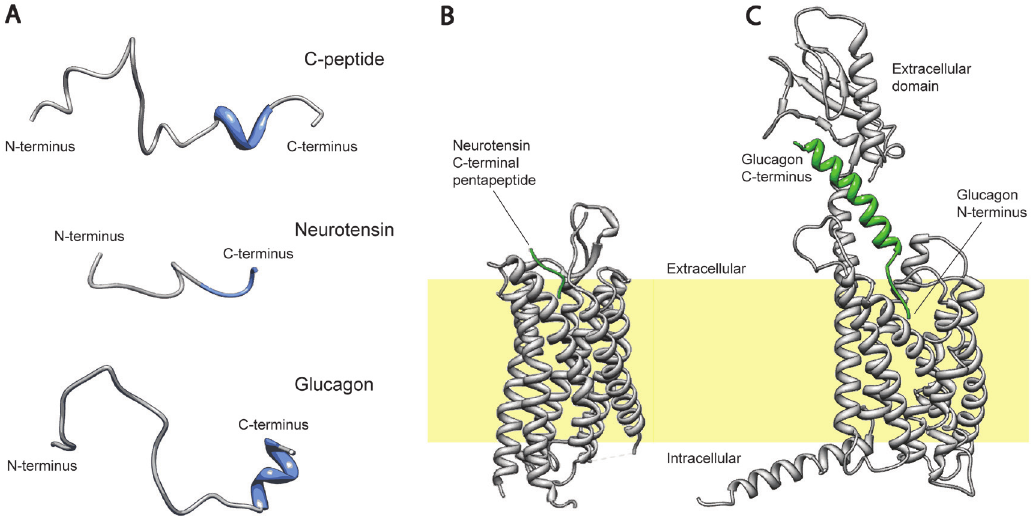
Figure 4 Possible models for C-peptide-mediated receptor signaling. (A) A comparison of the structures of C-peptide in 50% TFE (top, PDB ID 1T0C), neurotensin in the presence of lipid bicelles (middle,